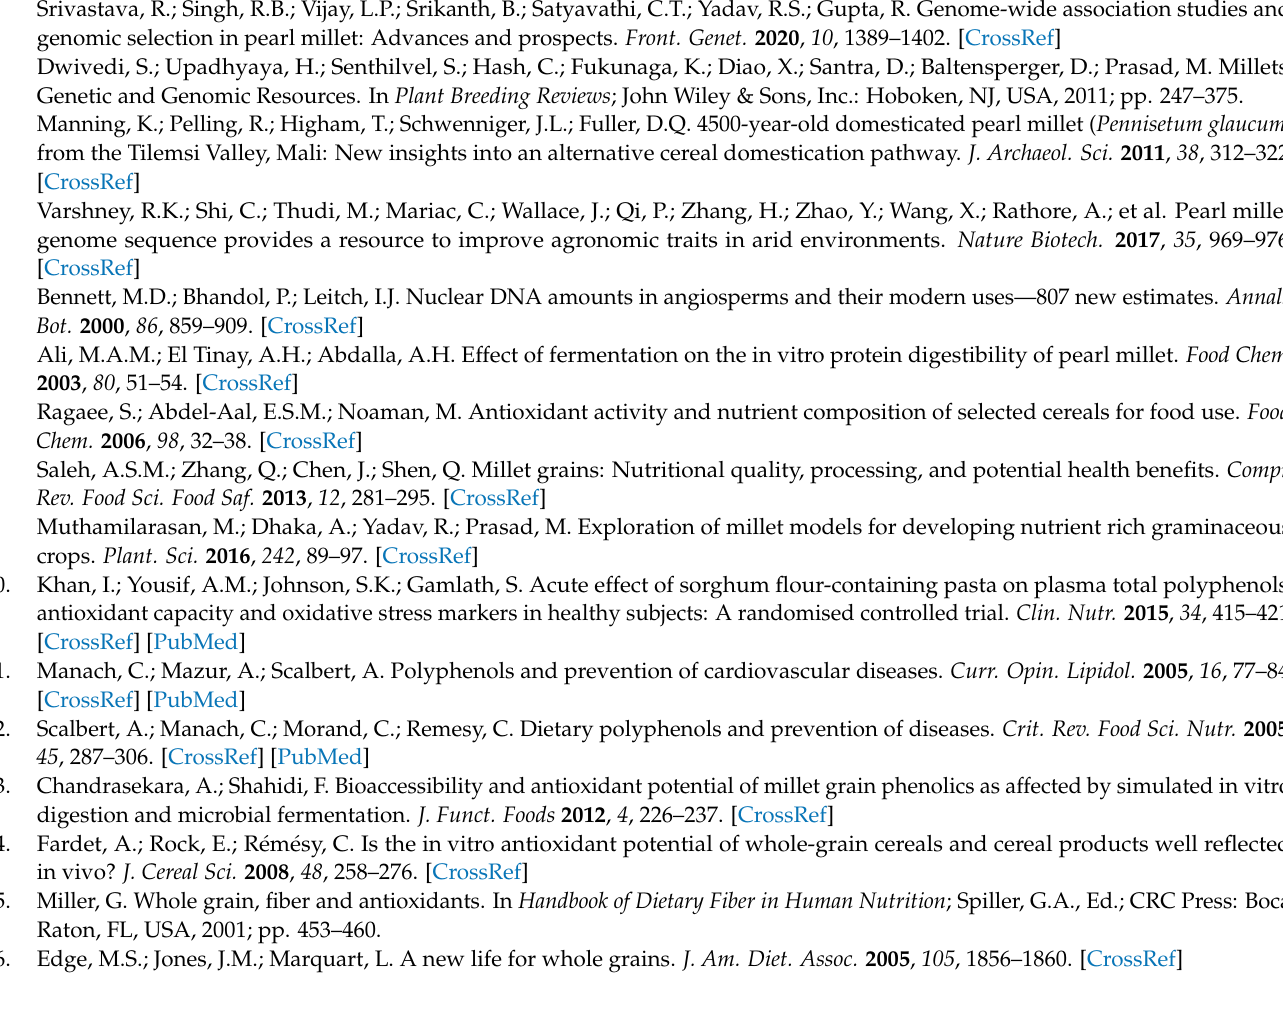
Figure S1: The heatmaps exhibit differential metabolites in pairwise comparison among the 197 pearl millet accessions. Figure S2: Dendrogram analysis showing distinct metabolites clustering among the 197 pearl millet